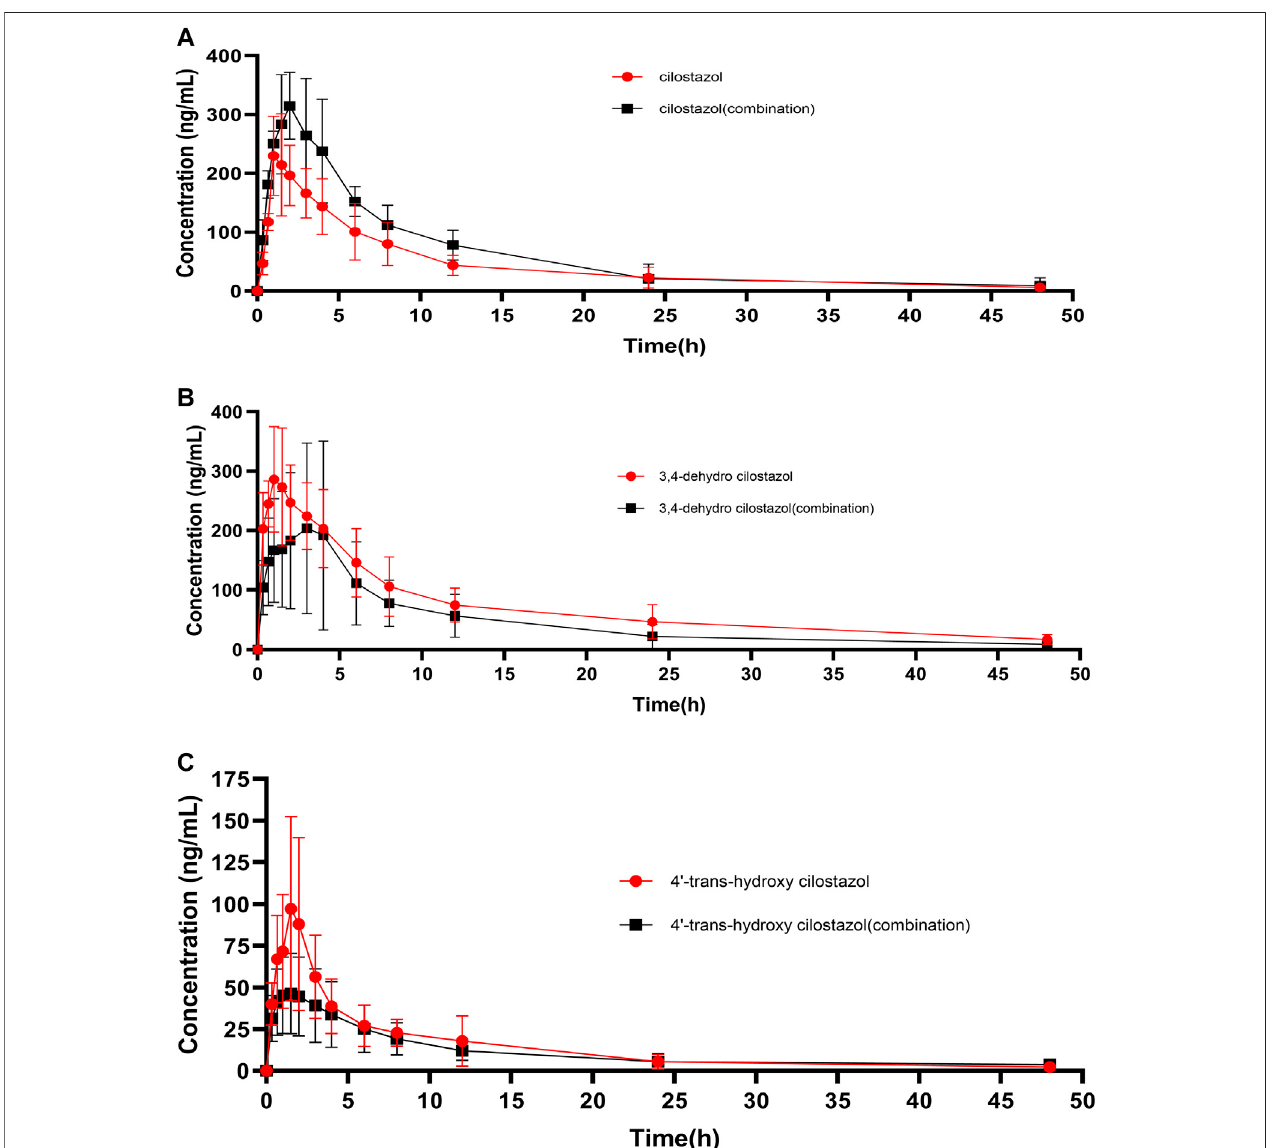
FIGURE 3 | Mean plasma concentration-time curves of cilostazol and its two metabolites in rats after oral administration of 10 mg/kg cilostazol with or without 80 mg/kg baicalein ( n = 6).